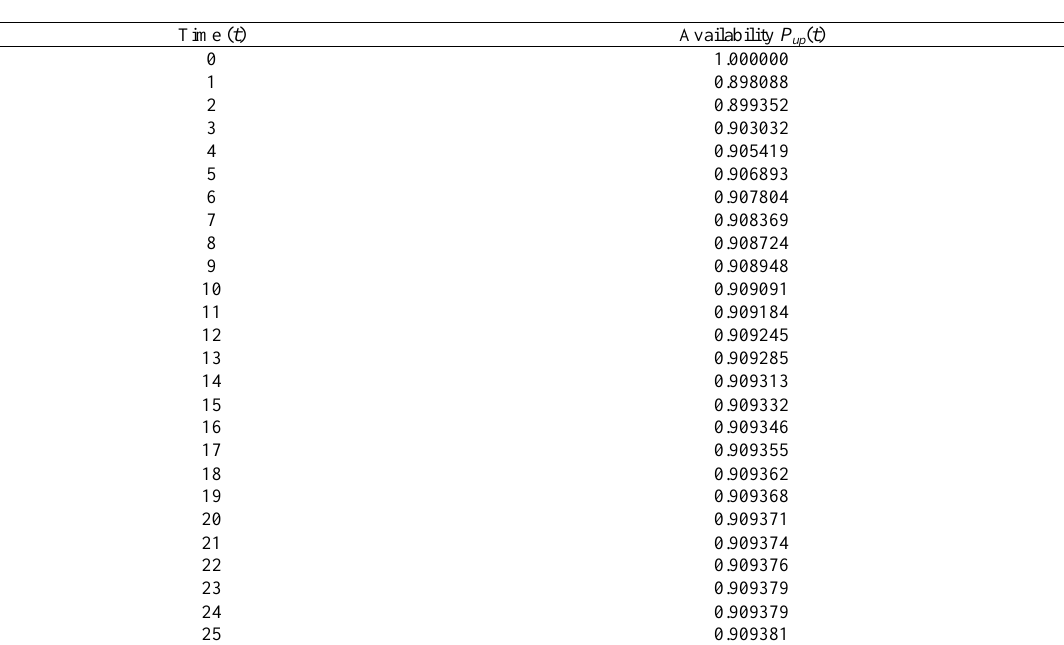
Table 3. Availability of the system with